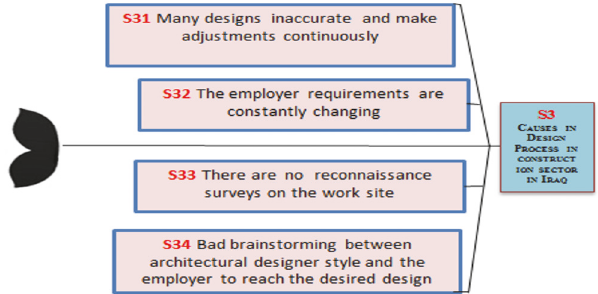
Figure 7: Fishbonediagram for project design managementprocess group.